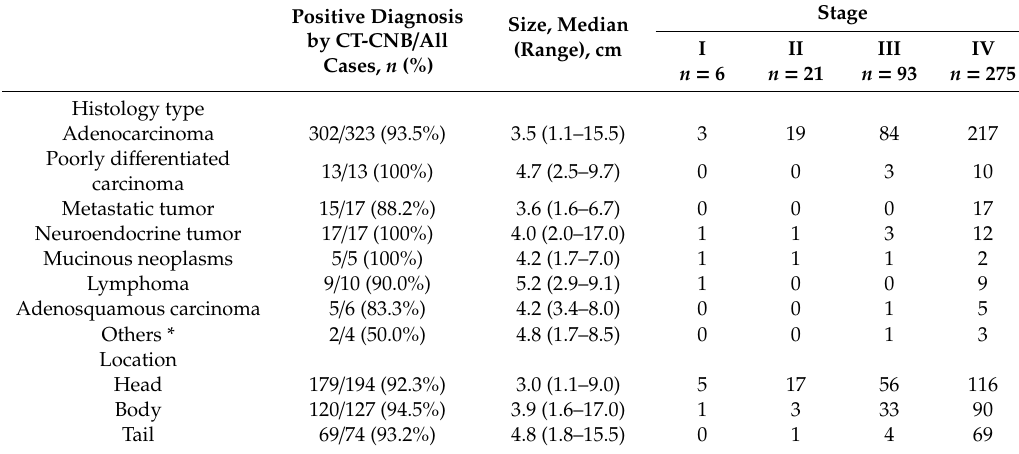
Table 2. Characteristics of 395 confirmed pancreatic